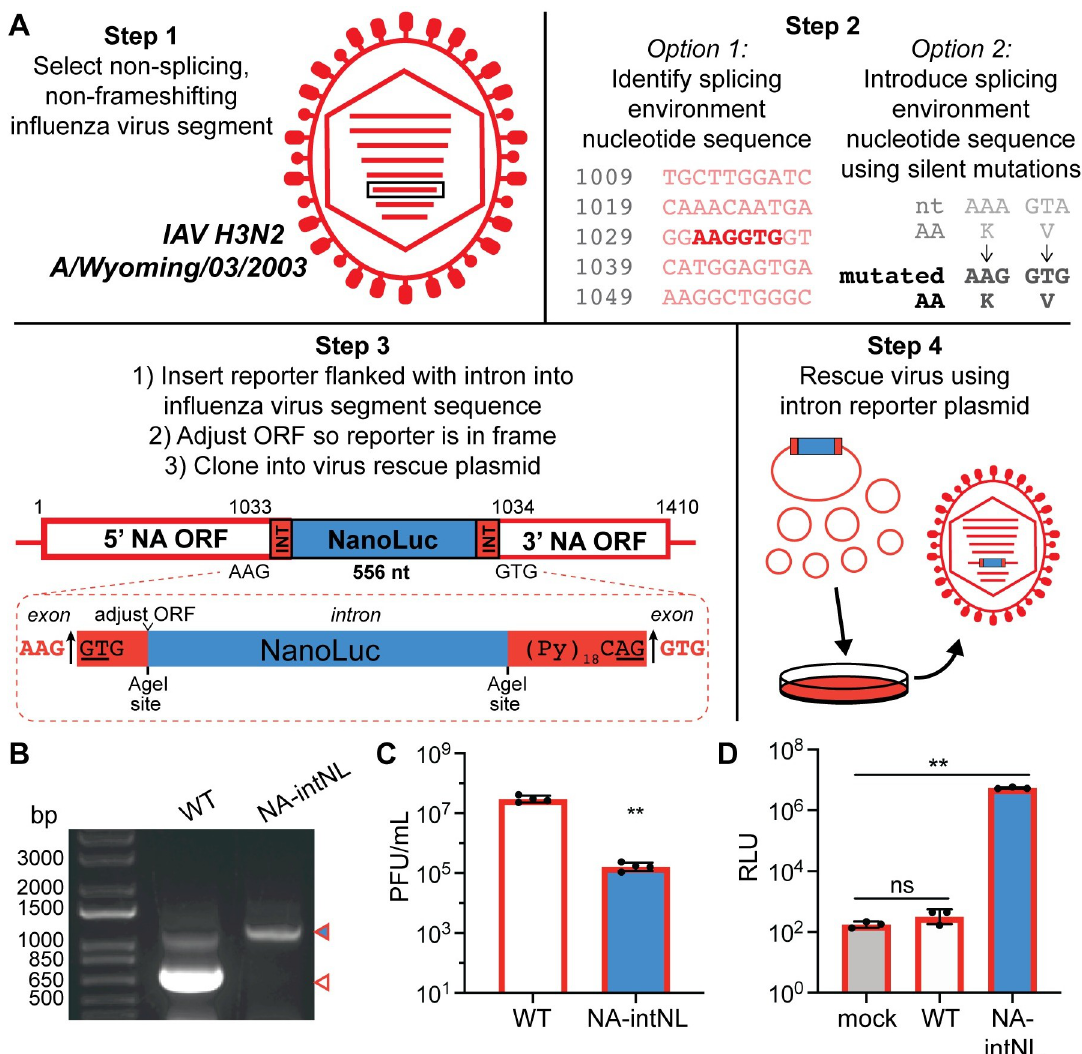
Fig 7. Artificial intron insertion can be used to develop reporter strains in different viral genetic backgrounds. (A) Diagram demonstrating how to introduce an artificial intron encoding a reporter into non-splicing, non-frameshifting IAV segments using A/ Wyoming/03/2003 (H3N2) segment 6/NA as an example. (B) RT-PCR of WT Wyo/03 virus (white) and Wyo/03-NA-intNL virus (blue) segment 6/NA. (C) End point titers of WT Wyo/03 and Wyo/03-NA-intNL virus infections (MOI = 0.0001, multicycle, 72h) on MDCK cells, measured using plaque assays (mean with SD, n = 4 independent experiments, unpaired Student’s t-test). (D) Luciferase levels from WT Wyo/03 and Wyo/03-NA-intNL virus infections (MOI = 0.0001, multicycle, 24h) on MDCK cells (mean with SD, n = 3 independent experiments, unpaired Student’s t-test). For all panels: � P < 0.05, �� P < 0.001 and ns = not